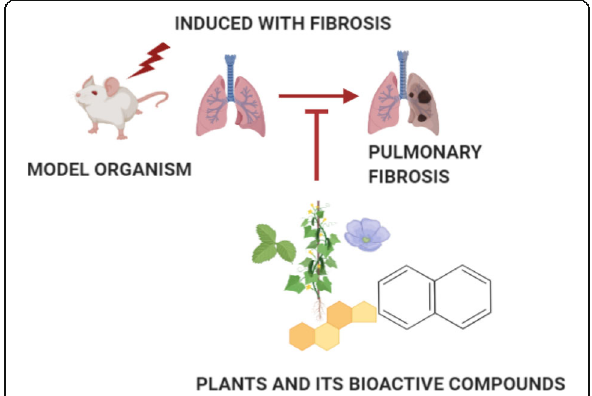
Fig. 4 Effect of plants and bioactive compounds in treating